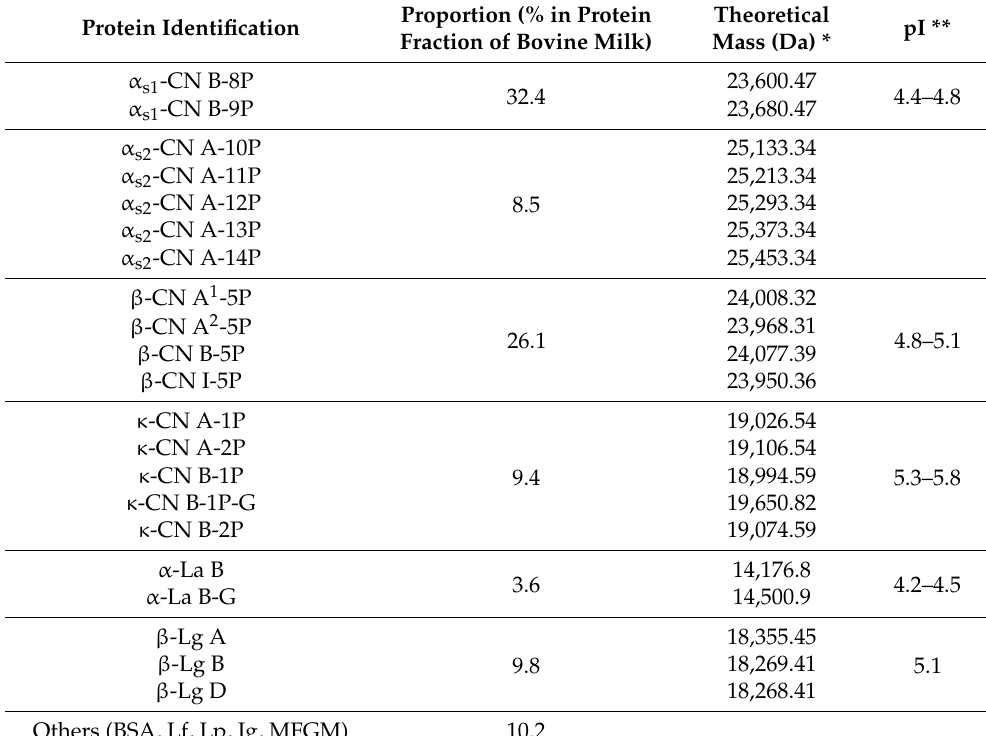
Table 2. Bovine milk proteins physico-chemical properties (adapted from * [49] and ** [50]). Proportion (% in Protein Protein Identification Fraction of Bovine Milk)